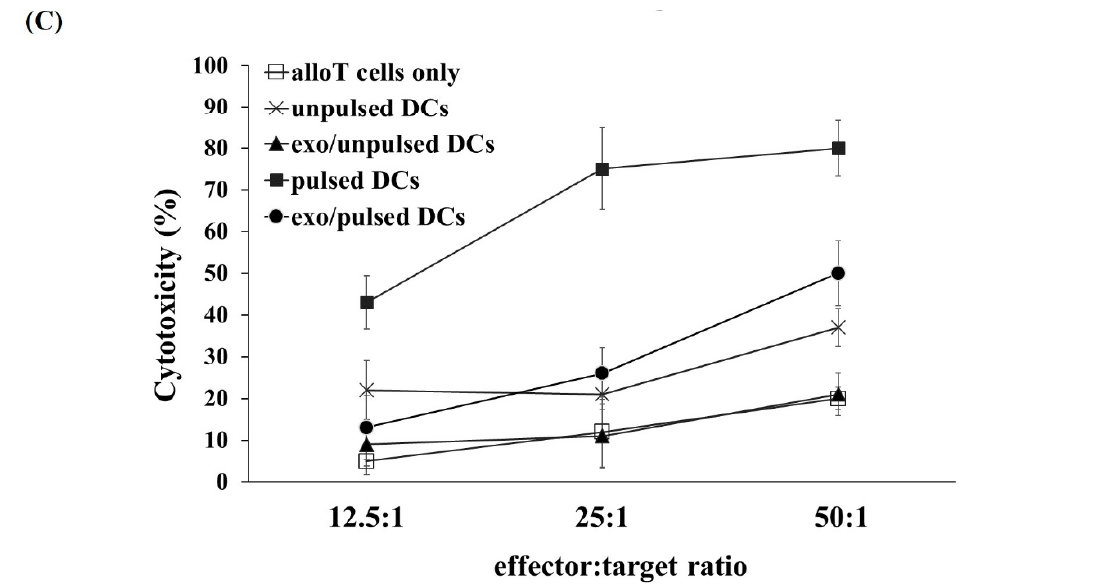
Figure 4. Cytotoxic activity of alloPBMCs in A549 lung cancer cells induced by DCs and DC-derived exosomes. ( A ) Calcein-AM-labeled A549 cancer cells were observed as green fluorescent dots. The signal clearly decreased in wells containing A549 cells incubated with pulsed DCs, exo / pulsed DCs and exo / unpulsed DCs-primed alloPBMCs (at an E:T ratio of 50:1). In contrast, no change was observed in wells containing A549 cells incubated with unprimed-alloPBMCs. ( B ) Cytotoxicity in A549 cells induced by primed-alloPBMCs compared to that of unprimed-alloPBMCs. Pulsed DCs and exo / pulsed DCs primed-alloPBMCs were the most cytotoxic to A459 cells at all tested ratios. Interestingly, exosomes isolated from unpulsed DCs also induced alloPBMCs cytotoxicity against cancer cells. ( C ) Cytotoxicity in A549 cells induced by primed-alloT cells compared to that of unprimed-alloT cells. Both pulsed DCs and exo / pulsed DCs-primed alloT cells had greater e ff ect on killing A549 cancer cells compared to unpulsed DCs at higher tested ratios. However, exosomes from unpulsed DCs showed no e ff ect on the induction of alloT cell cytotoxicity. Data was presented as mean ± SD in triplicate cultures for ( B ) and twice cultures for ( C ). alloPBMCs: allogeneic peripheral blood mononuclear cells; alloT cells: allogeneic T cells; DCs: dendritic cells; pulsed DCs: A549 tumor cell lysate-pulsed DCs; unpulsed DCs: A549 tumor cell lysate-unpulsed DCs; Exo / unpulsed DCs: exosomes isolated from unpulsed DCs; Exo / pulsed DCs: exosomes isolated from pulsed